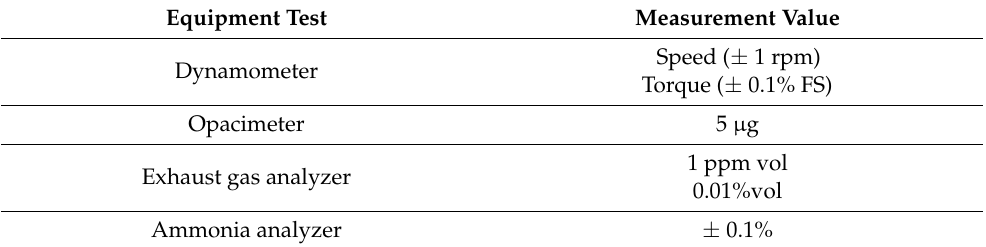
Table 10. Experimental setup, adapted from Bai et al. [44,92,114,119].